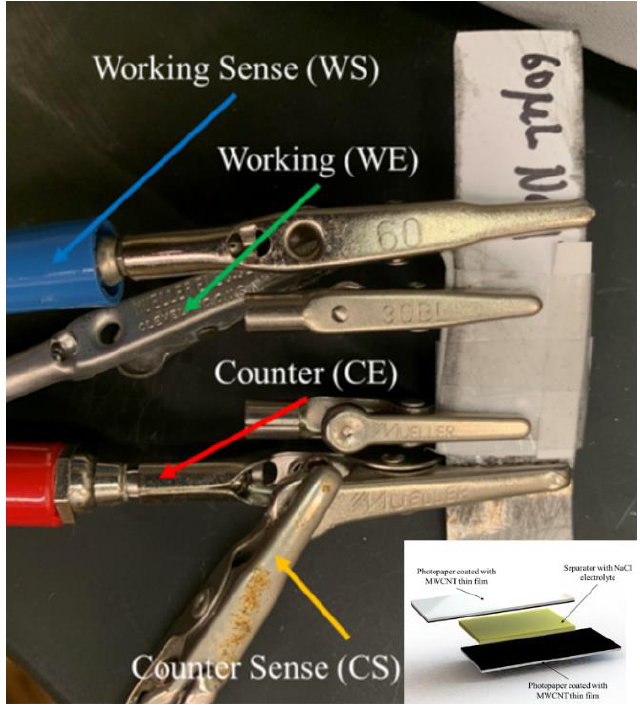
Figure 22. Photo and schematic of the capacitive device connected to the electrochemical measure- ment workstation. Thicknesses of layers in the schematic inset are exaggerated for visibility.